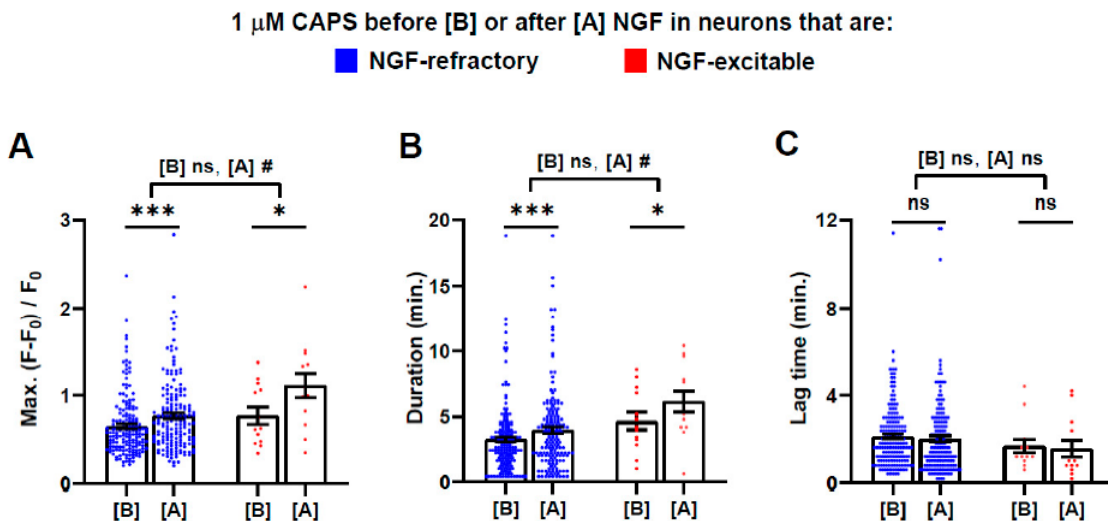
Figure 5. Acute sensitisation by NGF of responses to CAPS is most prevalent in cells that exhibit [Ca2+]i signals when the neurotrophin is applied. Neurons that responded to 1 µ M CAPS both times when it was applied before and after 5 min exposure to NGF (blue trace in Figure 1A) were split into two groups depending on whether they additionally exhibited Ca 2+ signals in response to NGF alone (red dots, n = 13 neurons from 3 DRG recordings) or did not (blue dots, n = 170). The analysis tools were applied to measure ( A ) Max. intensity, ( B ) signal duration and ( C ) lag time for the CAPS-evoked signals before [B] (on abscissa) and after [A] the treatment with NGF. Asterisks show significant differences within groups between responses before and after NGF treatment (Student’s t -test, paired samples; * p < 0.05; *** p < 0.001; ns, not significant). Hash tags display significant differences between NGF-refractory and -excitable cells, for responses to 1 µ M CAPS before [B] and after [A] NGF (Student’s t -test, unpaired samples, unequal variance; # p < 0.05; ns, not significant). Detailed results of analysis are given in Supplementary Table